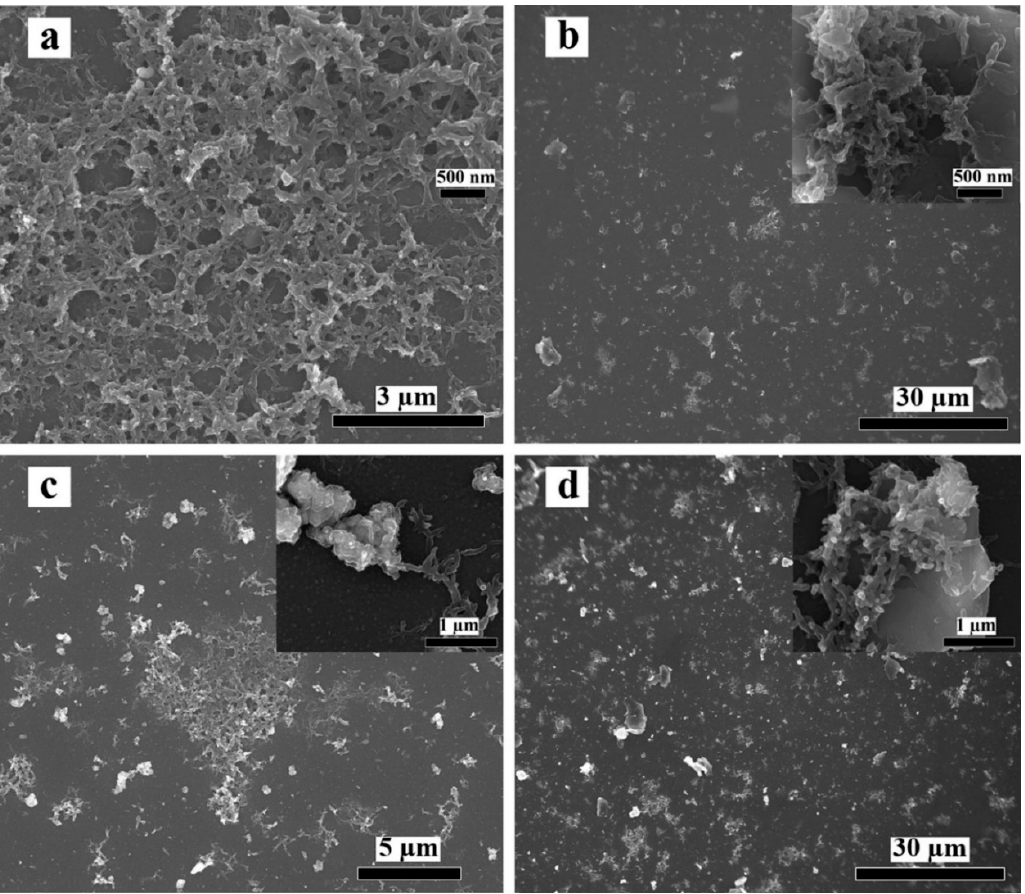
Figure 3. SEM images of ( a ) pristine PANI film, ( b ) graphene/PANI film, ( c ) WO 3 /PANI film, and ( d ) WO 3 /graphene/PANI film. Inset is the magnification of corresponding SEM image.